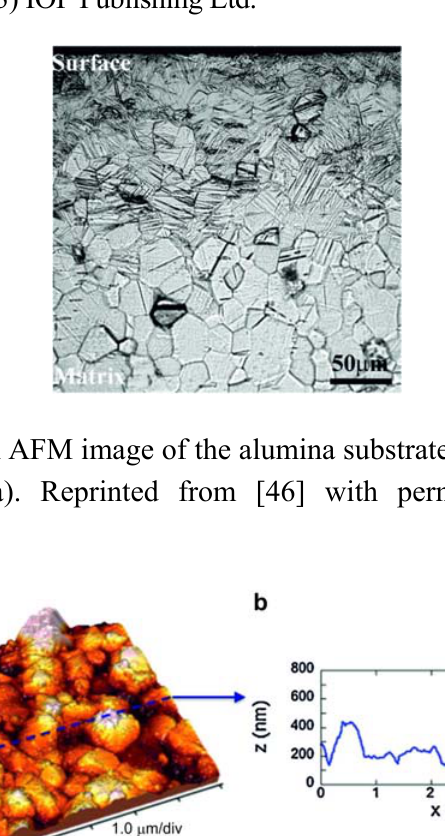
Figure 7. Optical micrograph of cross section of the SMATed-Ti. Reprinted from [55] with permission. Copyright (2013) IOP Publishing Ltd.